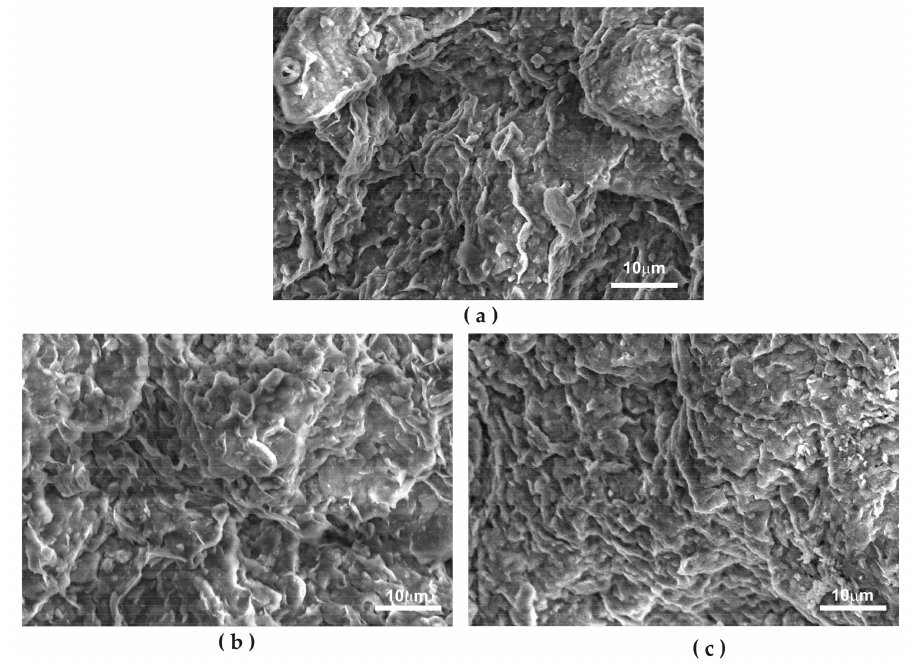
Figure 15. Change of fabric caused by porewater replacement: ( a ) initial saline clay fabric; ( b ) parallel fabric after porewater replacement with 1000 mg/L NaCl solution; ( c ) denser parallel fabric after porewater replacement with 6000 mg/L NaCl